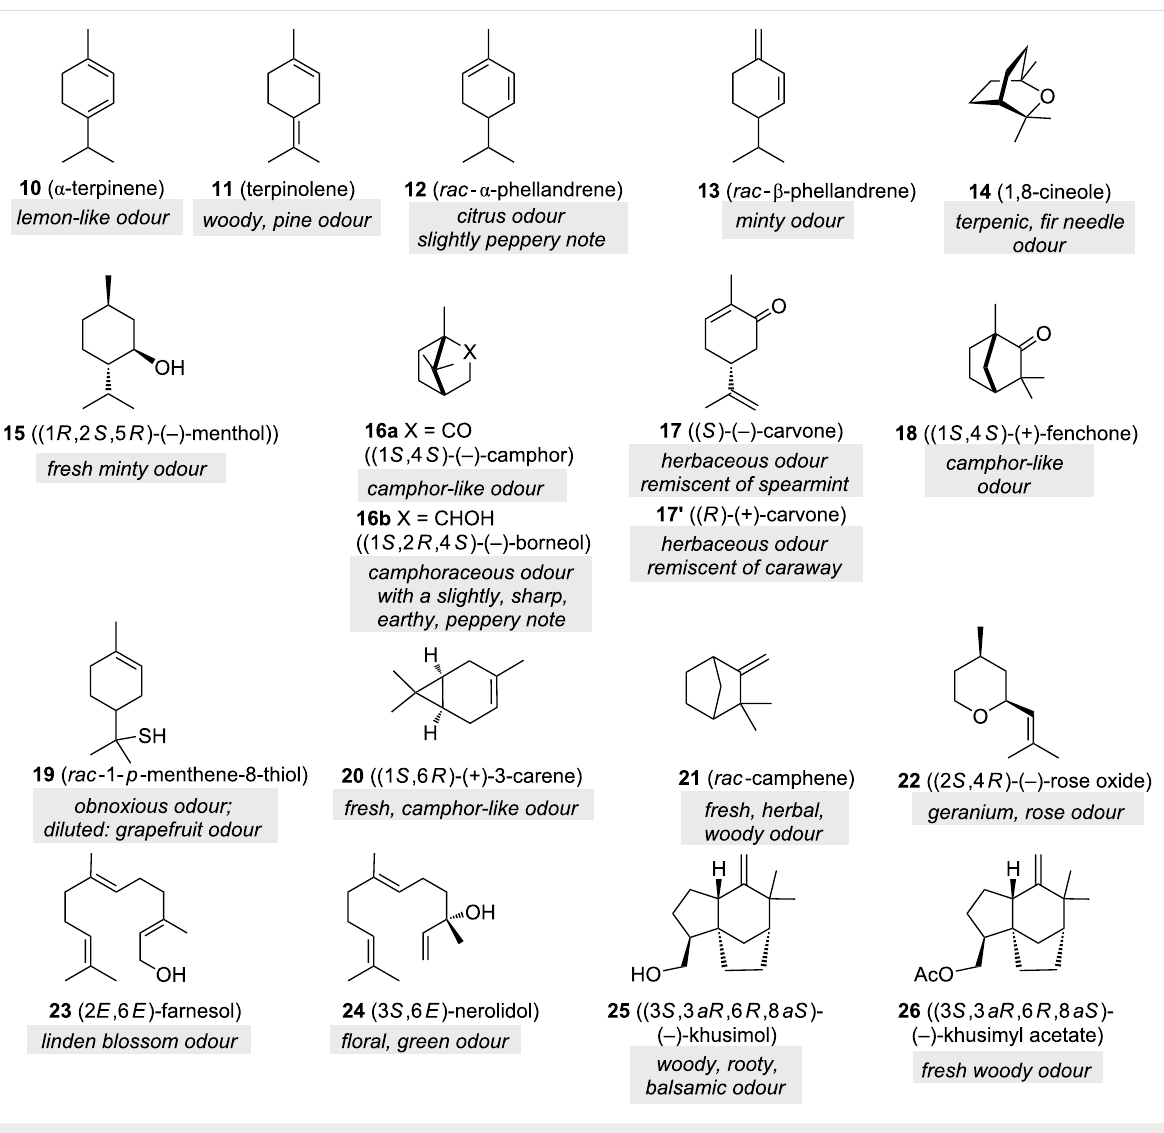
synthetic organic chemistry. This made odorants available for the broad masses and perfumes to be worn according to one’s daily mood